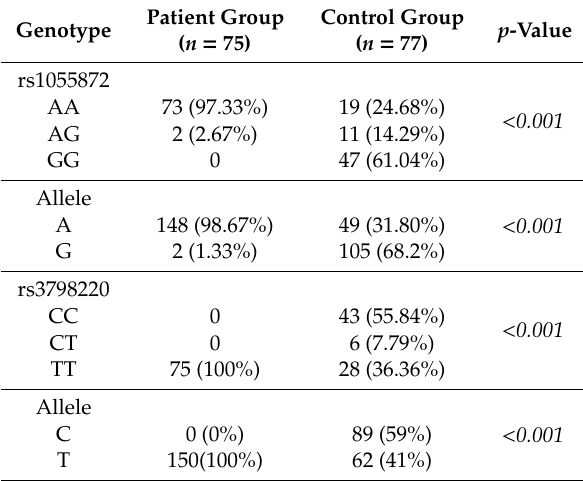
Table 2. Genotype / study population.